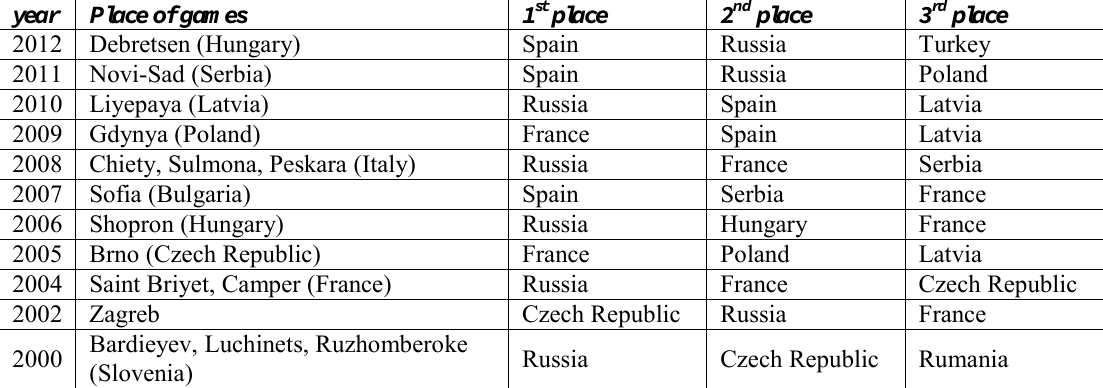
Prize winners of European Championship in basketball among women’s teams under 20.